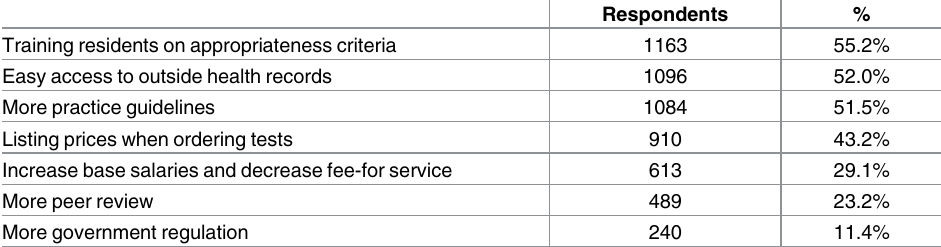
Table 4. Physician perceptions on potential solutions to overtreatment (N =